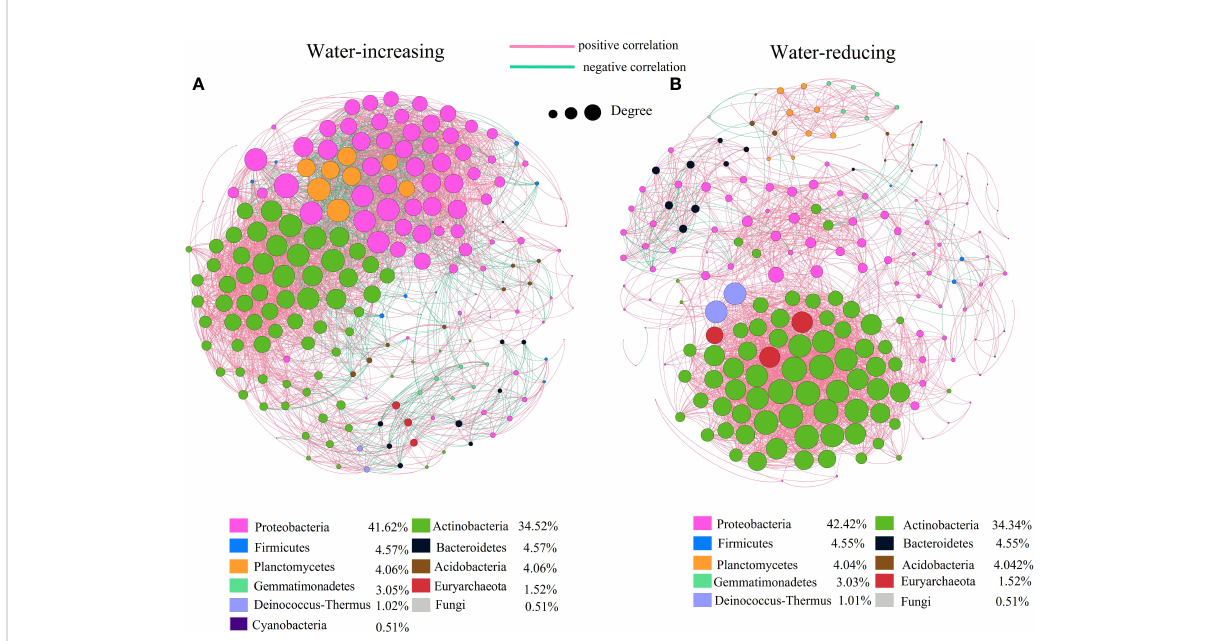
FIGURE 5 Network of co-occurring genera based on correlations analysis for water-increasing and water-reducing. A connection stands for a strong (Spearman ’ s p>0.7) and signi fi cant (p<0.01) correlation. The size of each node is proportional to the degree. Nodes colored by taxonomy, lines colored by positive and negative correlation, (A) water-increasing treatment, (B) water-reducing treatment.